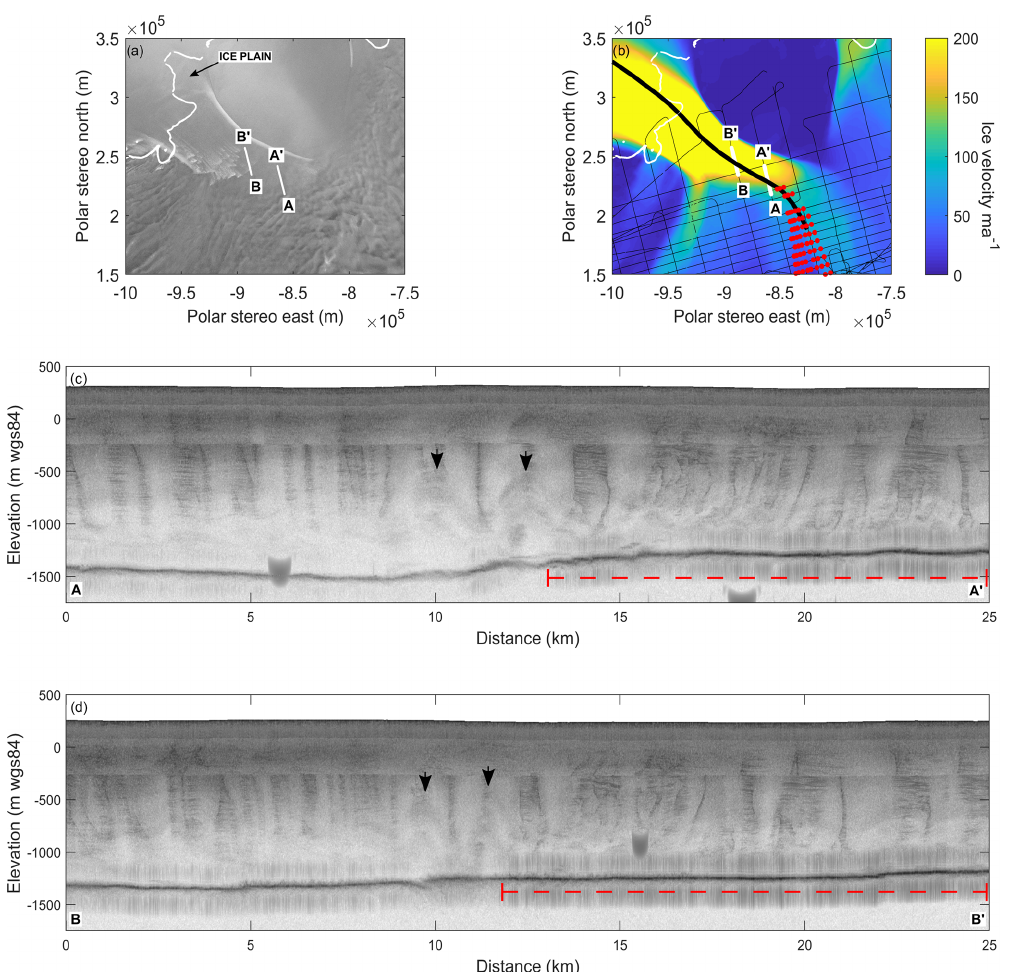
Figure 5. Englacial folds and ice flow of the IIS trunk: (a) RADARSAT image mosaic (Jezek et al., 2013) of the ice sheet surface of the IIS. Thick white lines show the positions of radar data shown in (c) and (d) . The thin white line is the grounding line (Rignot et al., 2011). The ice plain of the IIS is annotated. (b) Mapped englacial fold axes (red dots) and a prominent surface flow stripe (thick black line) mapped using RADARSAT and MODIS mosaics of Antarctica (Jezek et al., 2013; Haran et al., 2005), overlain on ice flow (Mouginot et al., 2019), the IMAFI survey grid (thin black lines), and the grounding line (thin white line) (Rignot et al., 2011). (c, d) Radar data across the IIS trunk oblique to the flow stripe and ice flow, showing the subtle signature of the most apparent englacial folding (two black arrows) within the faster-flowing trunk. The hand-shaped-reflection (HSR) fold is the fold indicated by the right of the two black arrows. A qualitative increase in basal reflectivity is apparent to the right of the HSR fold in both radargrams (indicated by the dashed red